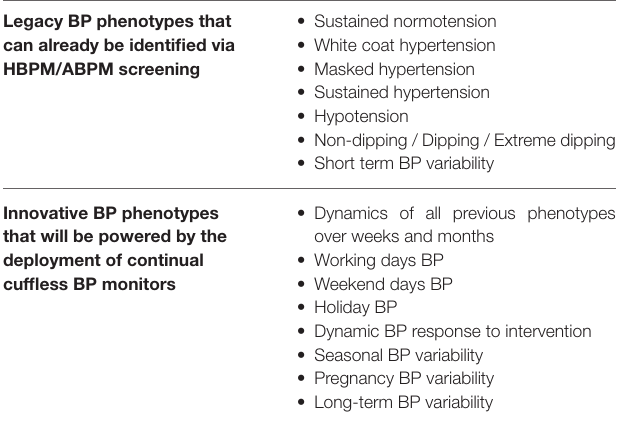
TABLE 5 | Suggested list of BP phenotypes that can already be identified via HBPM/ABPM screening, and extended list of BP phenotypes that will be powered by the deployment of continual cuffless BP